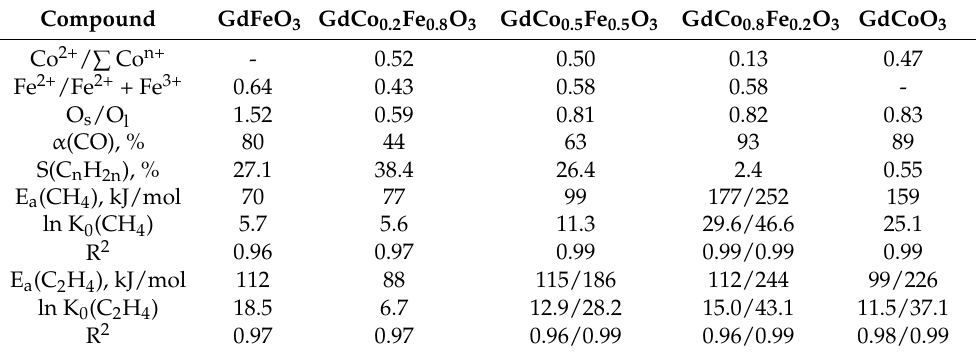
exponential multiplier also decreased. The activation energies of methane formation